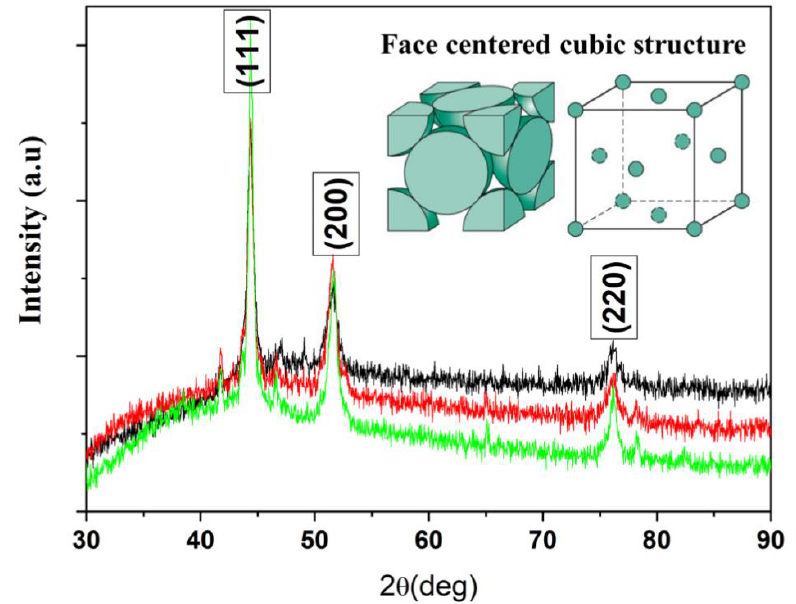
Figure 4. XRD pattern of three Ni – Co – P/Si 3 N 4 composite specimens prepared under the same con- ditions.